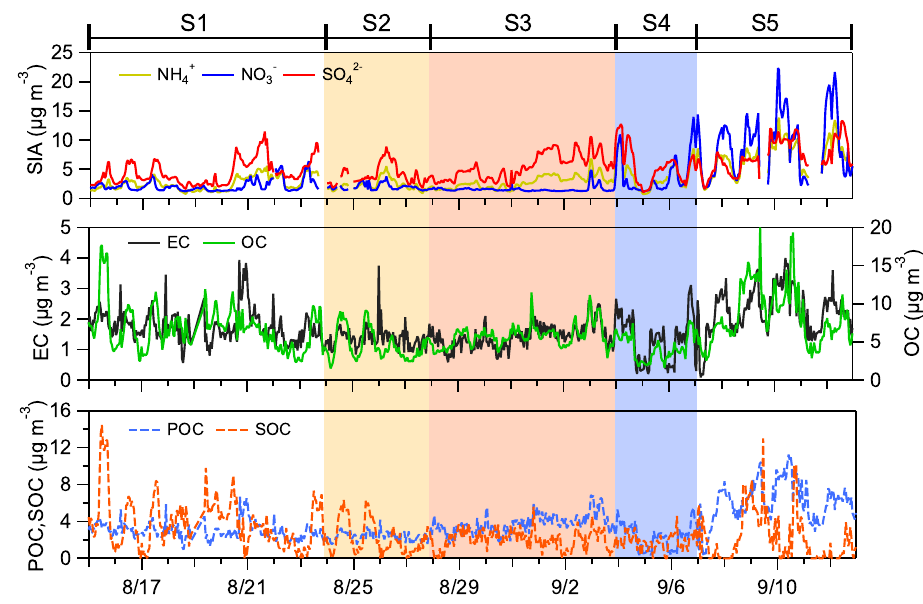
Figure 5. Time series of PM 2 . 5 chemical components during the entire study